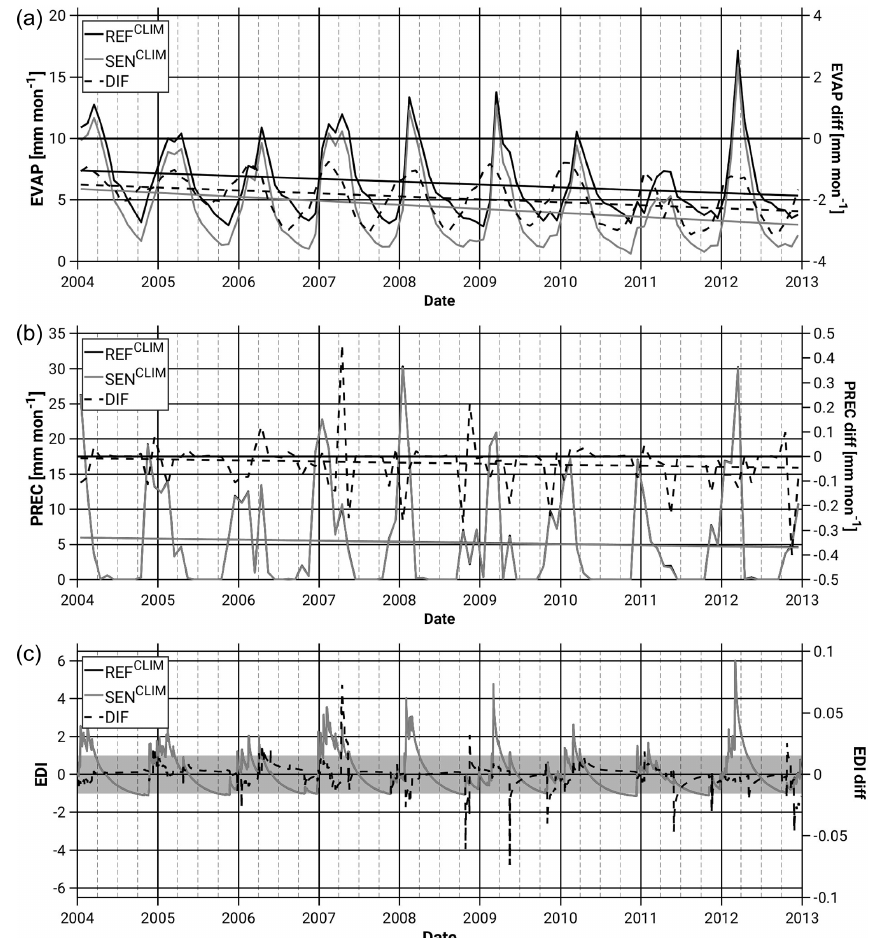
Figure 4. Temporal evolution of the area-averaged monthly accumulated values of (a) evaporation, (b) precipitation and (c) Effective Drought Index (EDI) from the REF CLIM (full black line) and the SEN CLIM (full grey line) simulations and differences depicted with black dashed lines. The light grey band in (c) indicates the common soil state ( − 1 < EDI < + 1). All grid points in the study area (Fig. 1) and the period 2004 to 2013 are